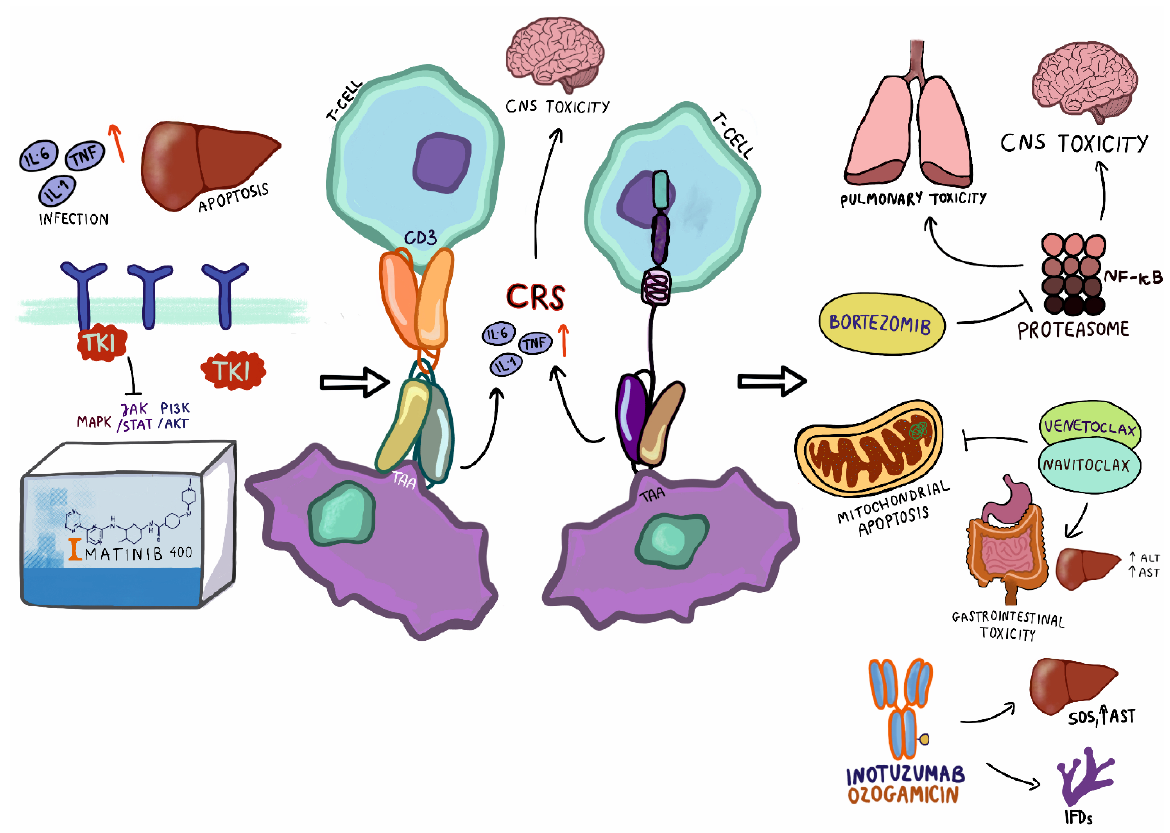
Figure 1. Toxicities associated with targeted therapy in pediatric patients with ALL. TKI—tyrosine kinase inhibitor; TNF—tumor necrosis factor; TAA—tumor-associated antigen; CNS—central nervous system; ALT—alanine transaminase; AST—aspartate transaminase, SOS—sinusoidal obstruction syndrome.